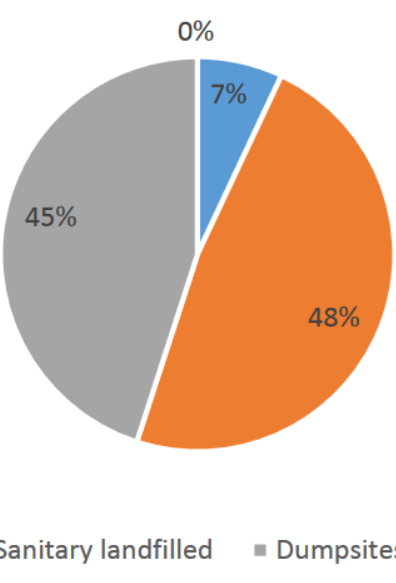
Figure 2: Percentages of waste disposal methods by GIZ (2014) report